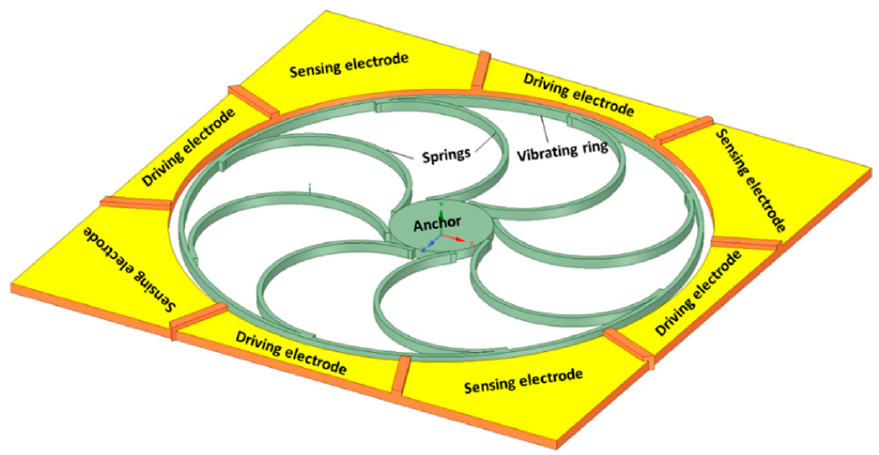
Figure 13. Schematic representation of the basic design of a vibrating ring gyroscope.